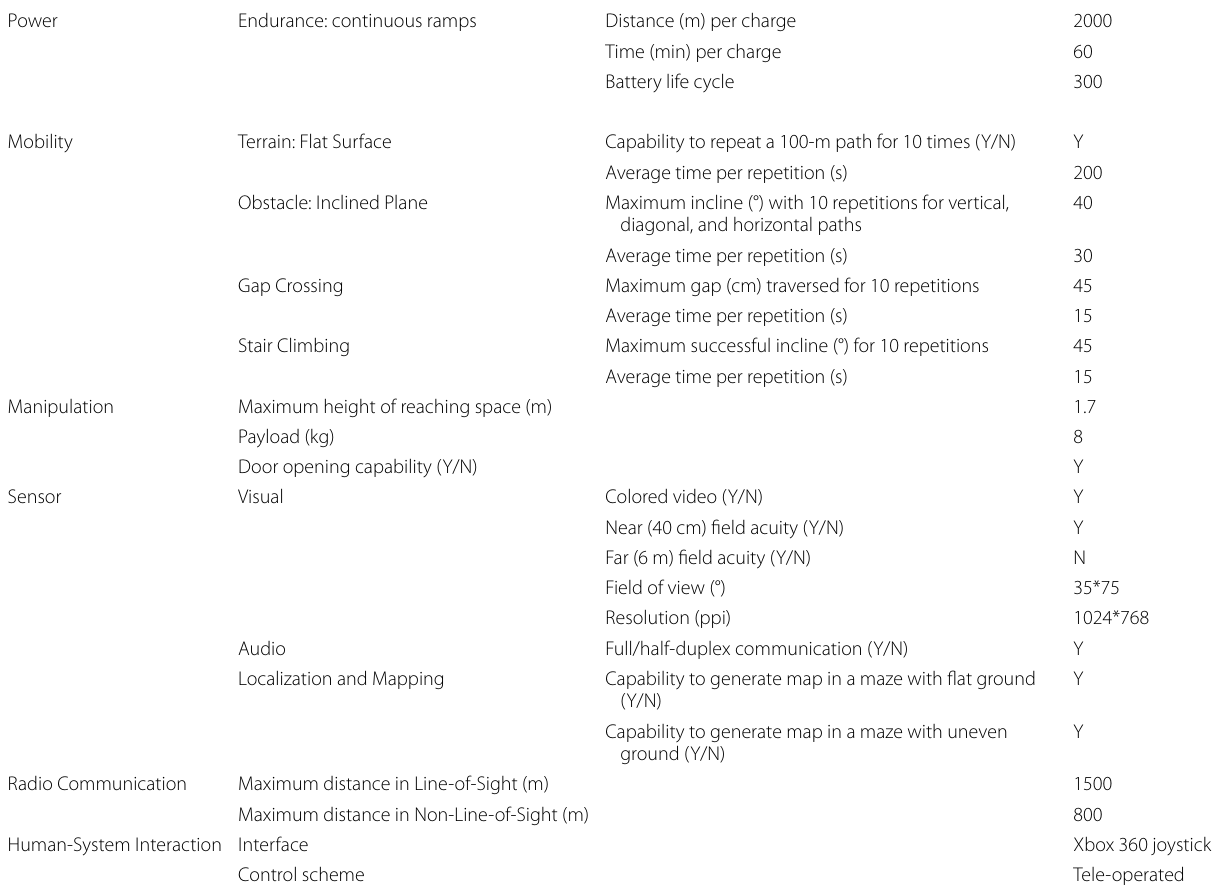
Table 1 System requirements of